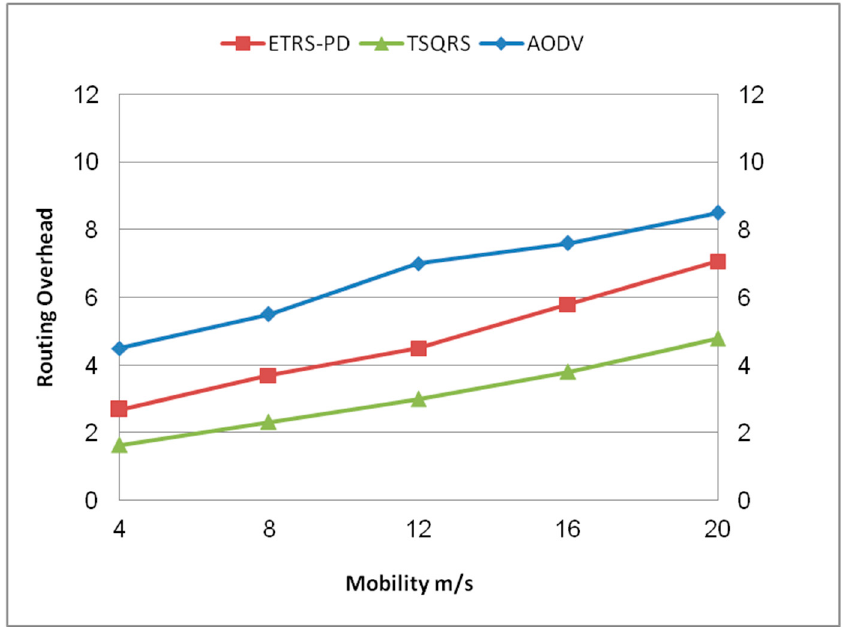
Figure 6. Routing overhead (RO) against mobility.